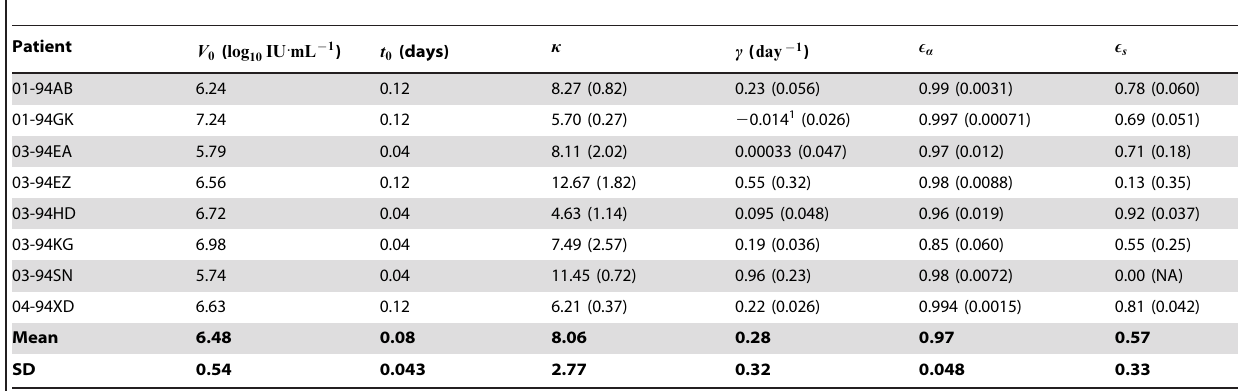
Table 3. Parameter values with standard errors in parenthesis estimated by fitting the long-term approximation to viral load data and assuming a ~ 400 day { 1 , r ~ 0 : 818 day { 1 , and other fixed parameters as given in Table 2 caption.